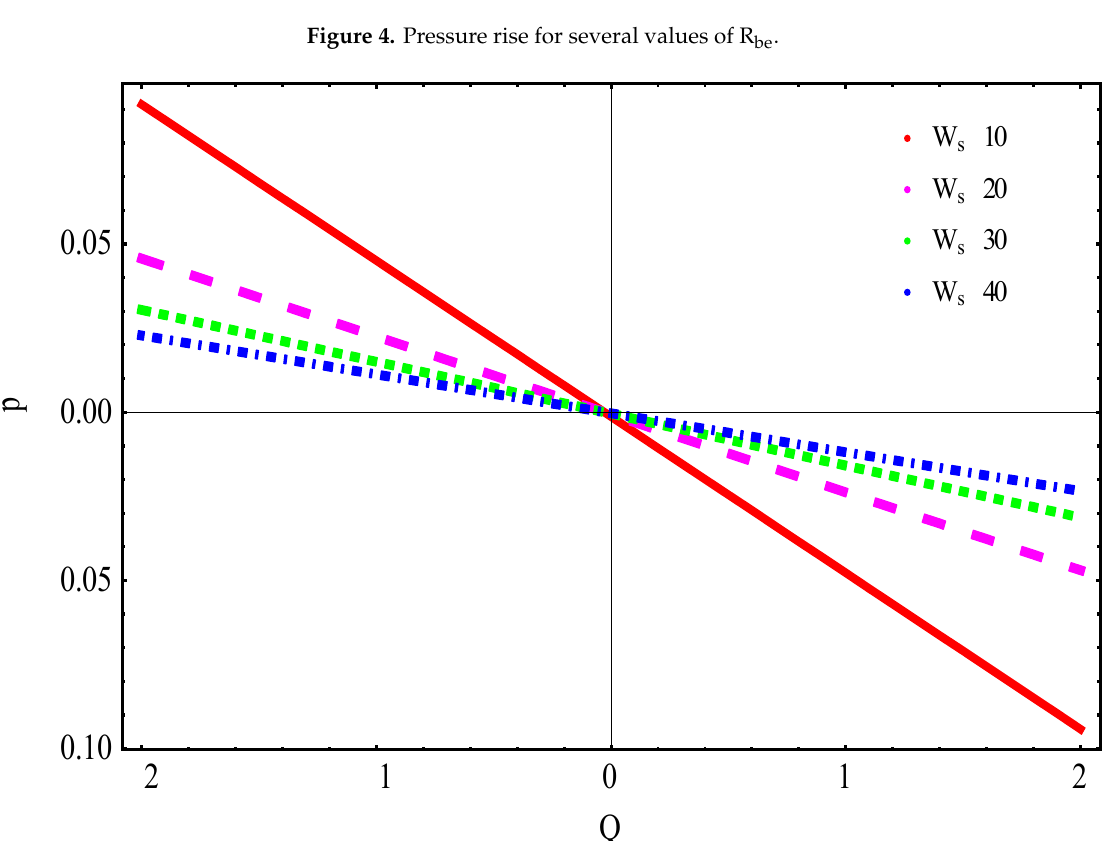
Figure 4. Pressure rise for several values of R be .